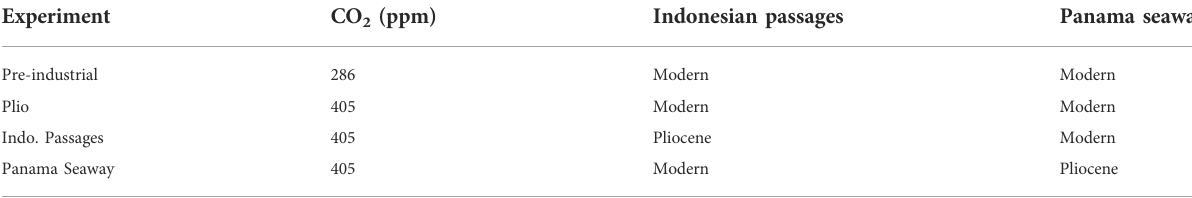
TABLE 1 Experimental setup for the coupled